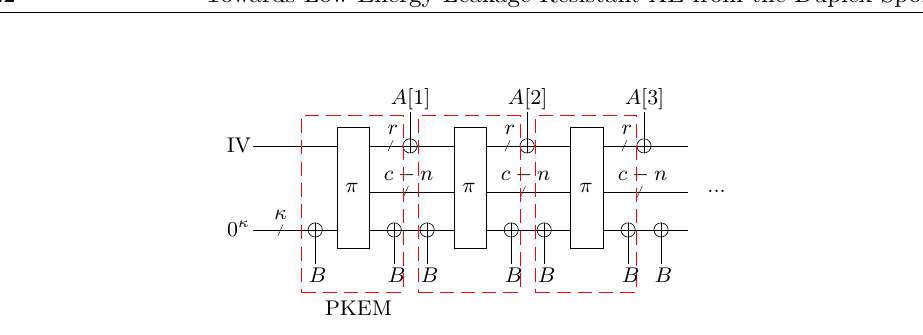
Figure 5: The PKEM-based representation of a keyed sponge with κ -bit key/initial seed B . The “partial-key” Even-Mansour cipher is inside the dashed rectangles. Internal actions of XORing B cancel. The construction turns basically the same as the keyed